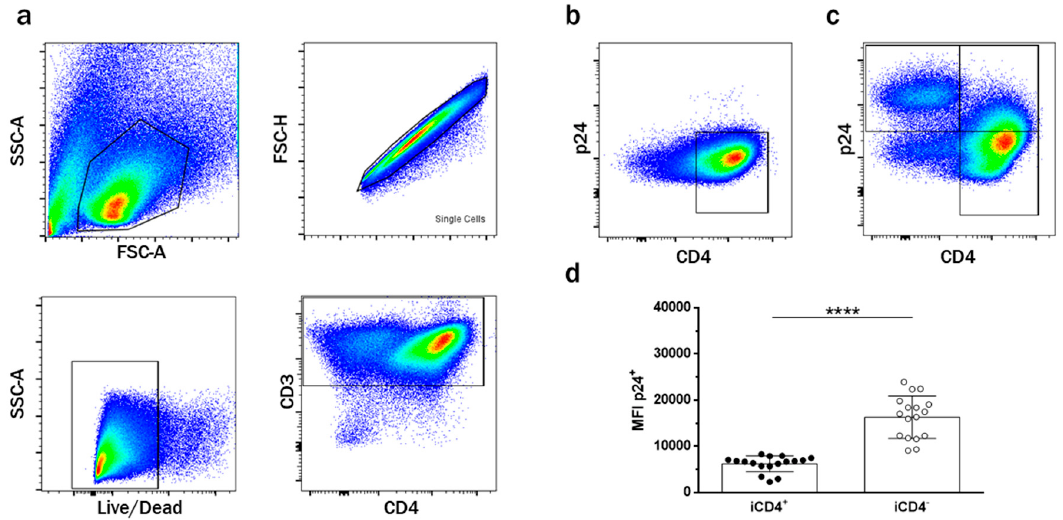
Figure 1. Gating strategy. ( a ) Gating strategy identifying live singlet CD3 + T lymphocytes. HIV-uninfected CD4 + T cells were identified from this gate ( b ); as were the different subsets of HIV-infected CD4 + T cells ( c ); ( d ) comparison of the mean fluorescence intensity (MFI) of p24 expression on HIV-infected p24 + CD4 + (iCD4 + ) and HIV-infected p24 + CD4 − (iCD4 − ) T cells ( n = 17). A Wilcoxon test was used to determine significance of within subject differences for the indicated T cell subsets. Each data point represents a separate infection of CD4 + T cells isolated from one individual. Bar height and error bars represent the mean and standard deviation for the data set. Significant values are shown; **** p < 0.0001.